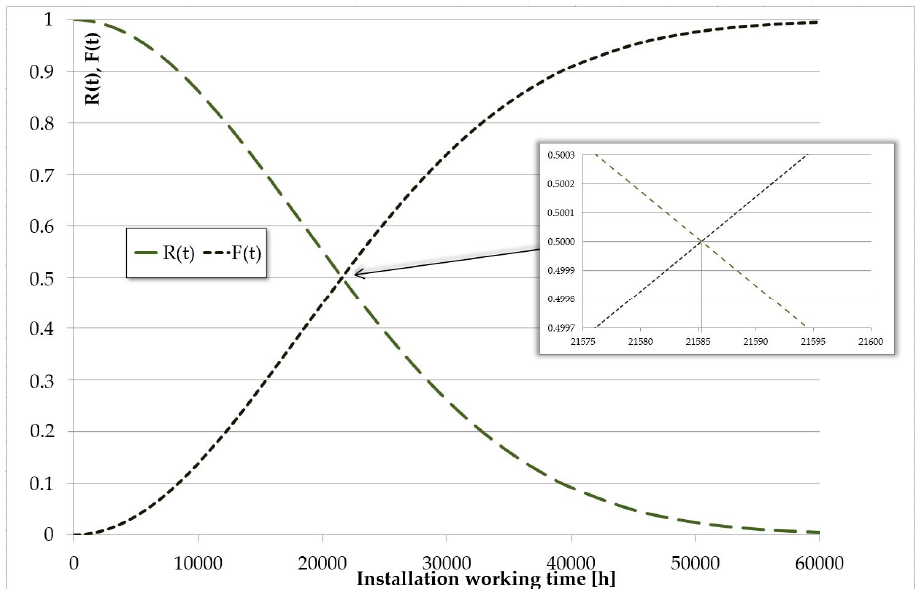
Figure 6. The distribution of the reliability function R(t) of the CHP plant in time.